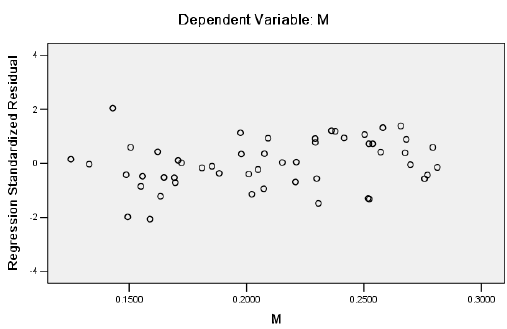
Figure 5. Regression standardized residuals of model at 2 kHz.